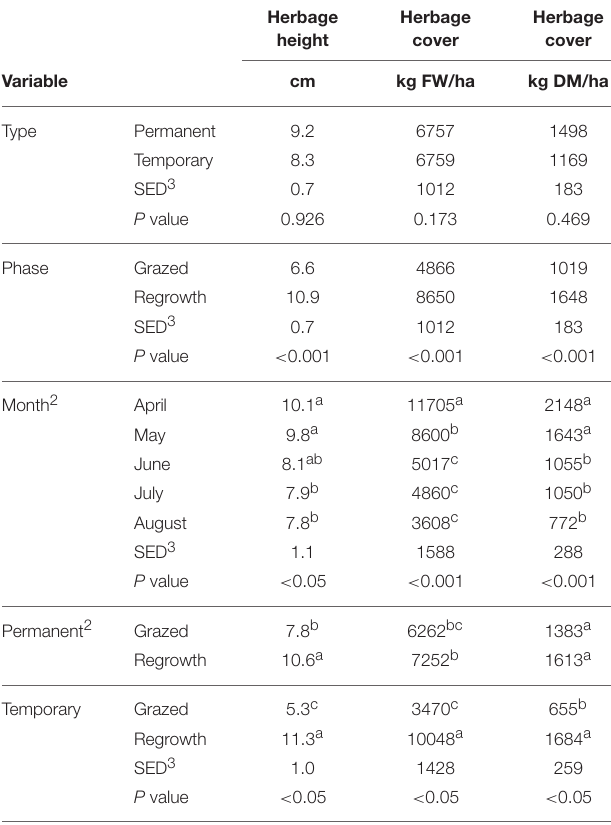
TABLE 3 | Average pasture height, herbage cover, and nutrient concentrations across fields, and weeks of the study. Variable